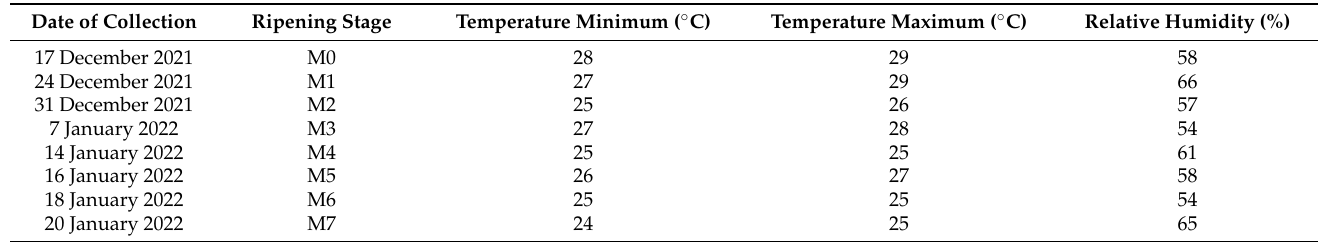
Table 1. The minimum to maximum temperatures and relative humidity of mulberry fruits with seven ripening